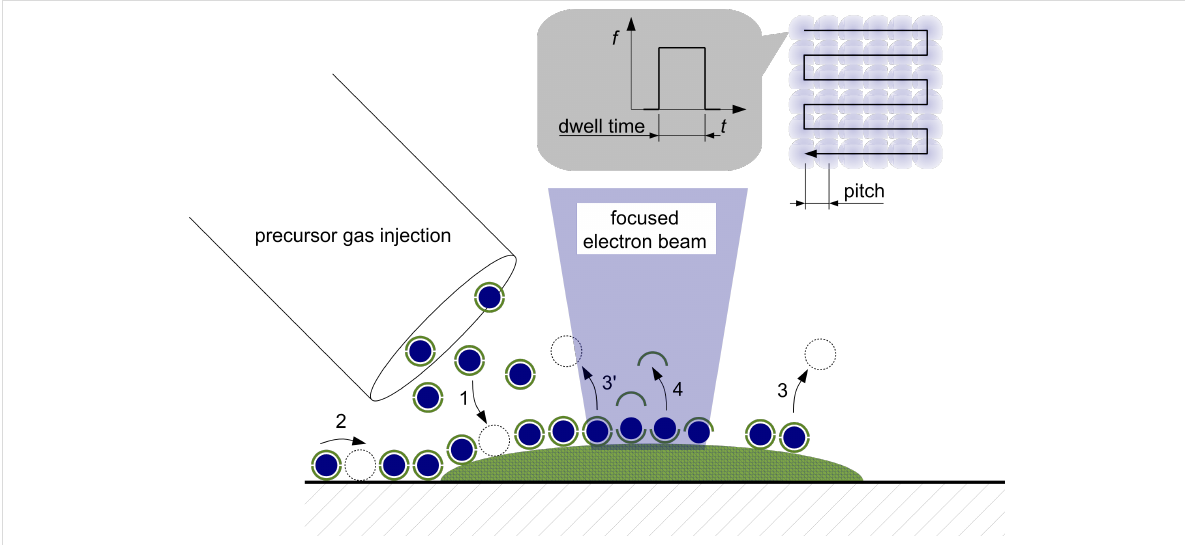
Figure 1: Illustration of FEBID. Precursor molecules (here: organometallic complex; blue: metal, green: organic ligands) are supplied by a gas-injec- tion system and physisorb (1) on the surface. Surface diffusion (2), thermally induced desorption (3) and electron-stimulated desorption (3') take place. Within the focus of the electron beam, adsorbed precursor molecules are (partly) dissociated followed by desorption of volatile organic ligands (4). Upper right: For pattern definition the electron beam is moved in a raster fashion (here: serpentine) over the surface and settles on each dwell point for a specified dwell time. After one raster sequence is completed the process is repeated until a predefined number of repeated loops is reached.